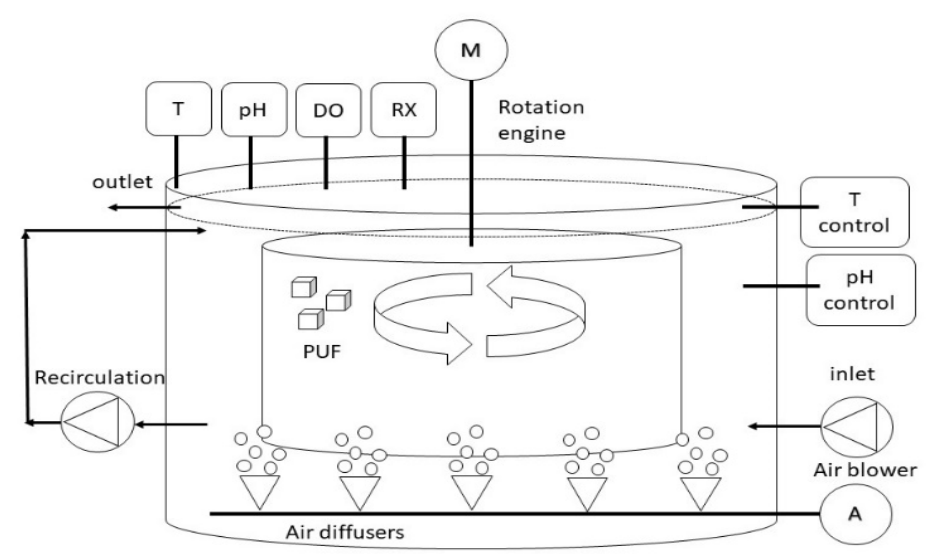
Figure 1. Schematic layout of the pilot-scale reactor. Temperature probe (T), dissolved oxygen probe (DO), redox probe (RX), polyurethane foam carriers (PUF), engine for rotation (M).